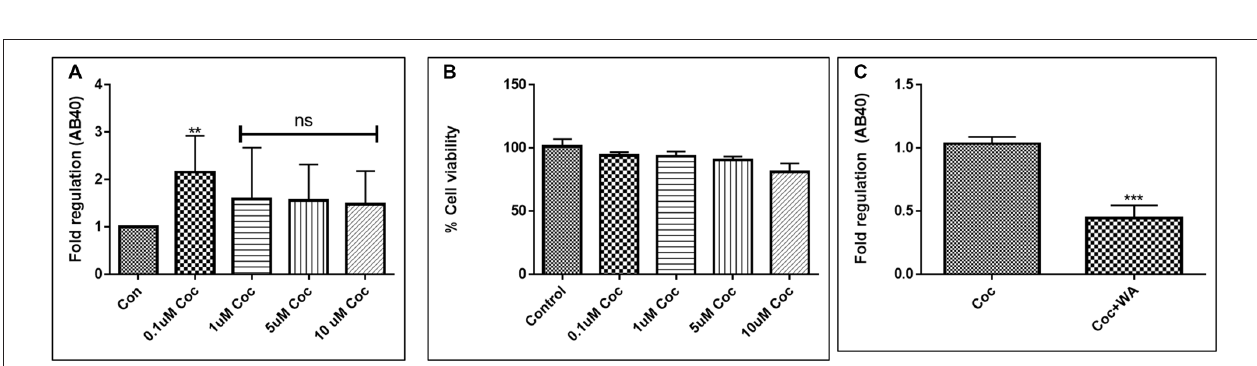
FIGURE 5 | Dose response. (A) Histograms showing Tat (5–100 ng/mL) increases the A β 1–40 levels. SHAPP cells were treated with different concentrations of Tat and after 48 h of treatment were analyzed by Flow cytometry for determining the A β 1–40 levels. (B) Quantification representation of the percent positive cells ( ∗∗∗∗ p ≤ 0.0001; ns: Non Significant).